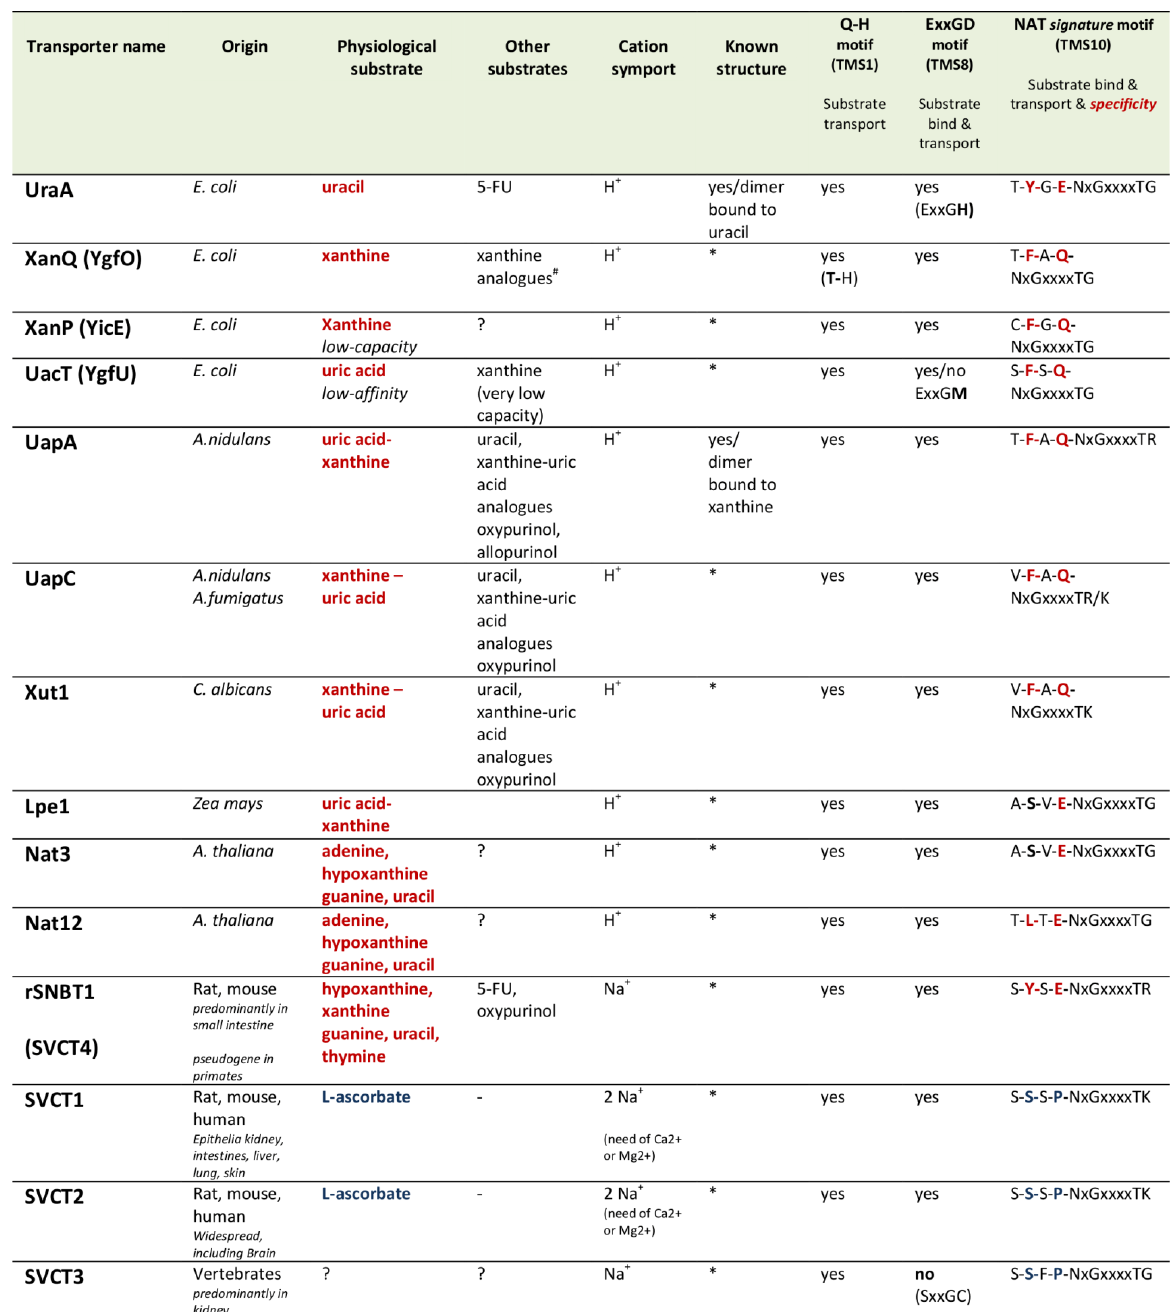
Table 1. Characteristics of biochemically characterized